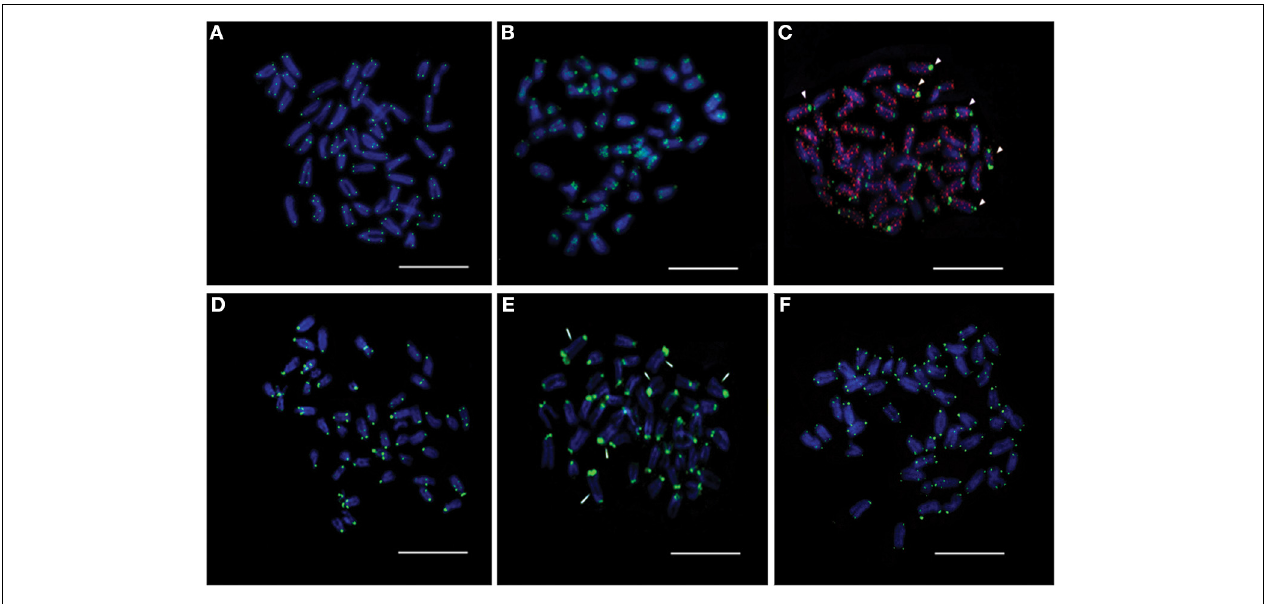
FIGURE 4 | The chromosomal distribution of seven cloned Asian seabass repeats determined by FISH assay. (A) Rex1_SB; (B) MAUI_SB; (C) YRep_SB (green) and GGSat_SB (red); (D) OnSat_SB;